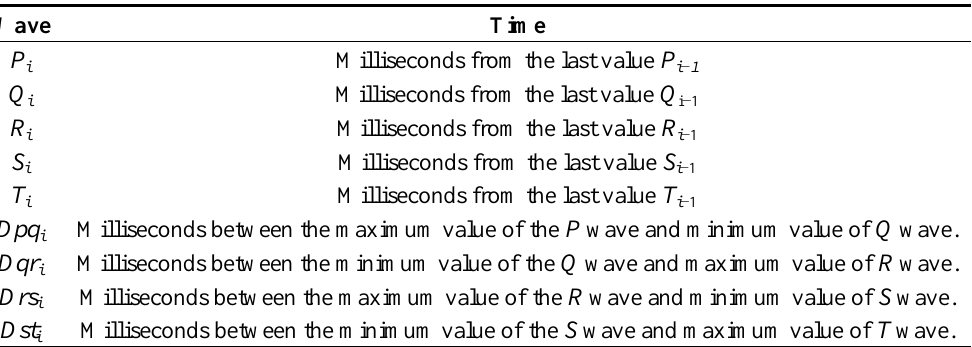
Table 1. EKG waves and